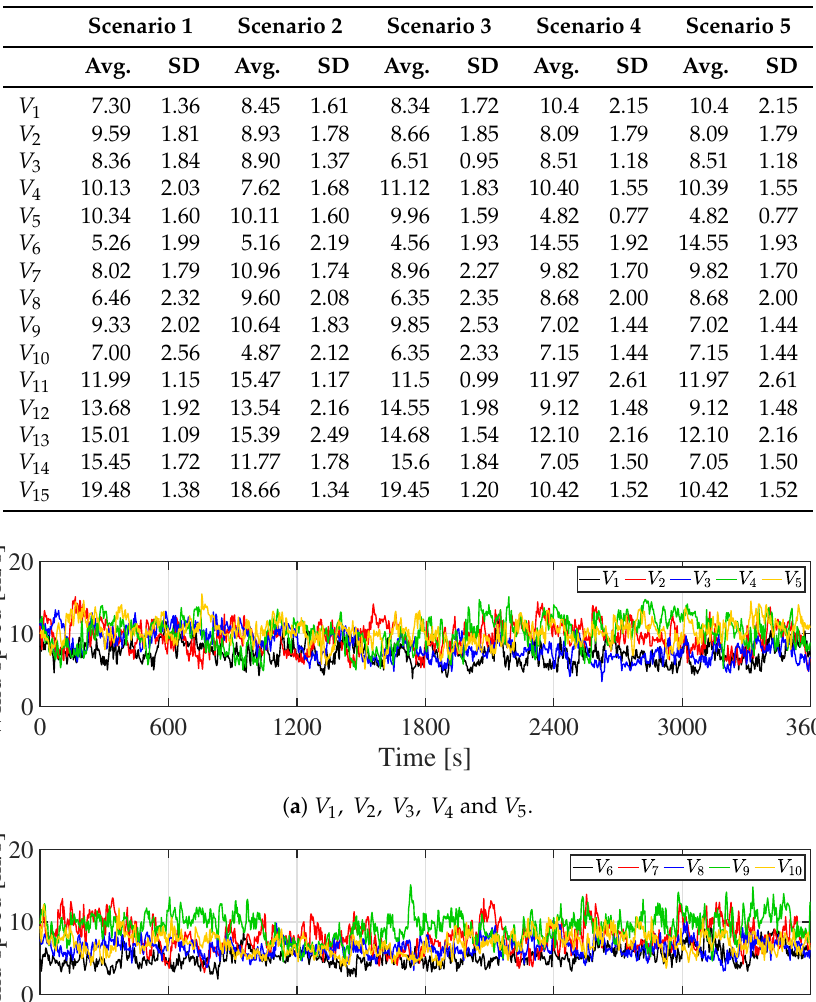
Table 2. Characteristics of wind data.